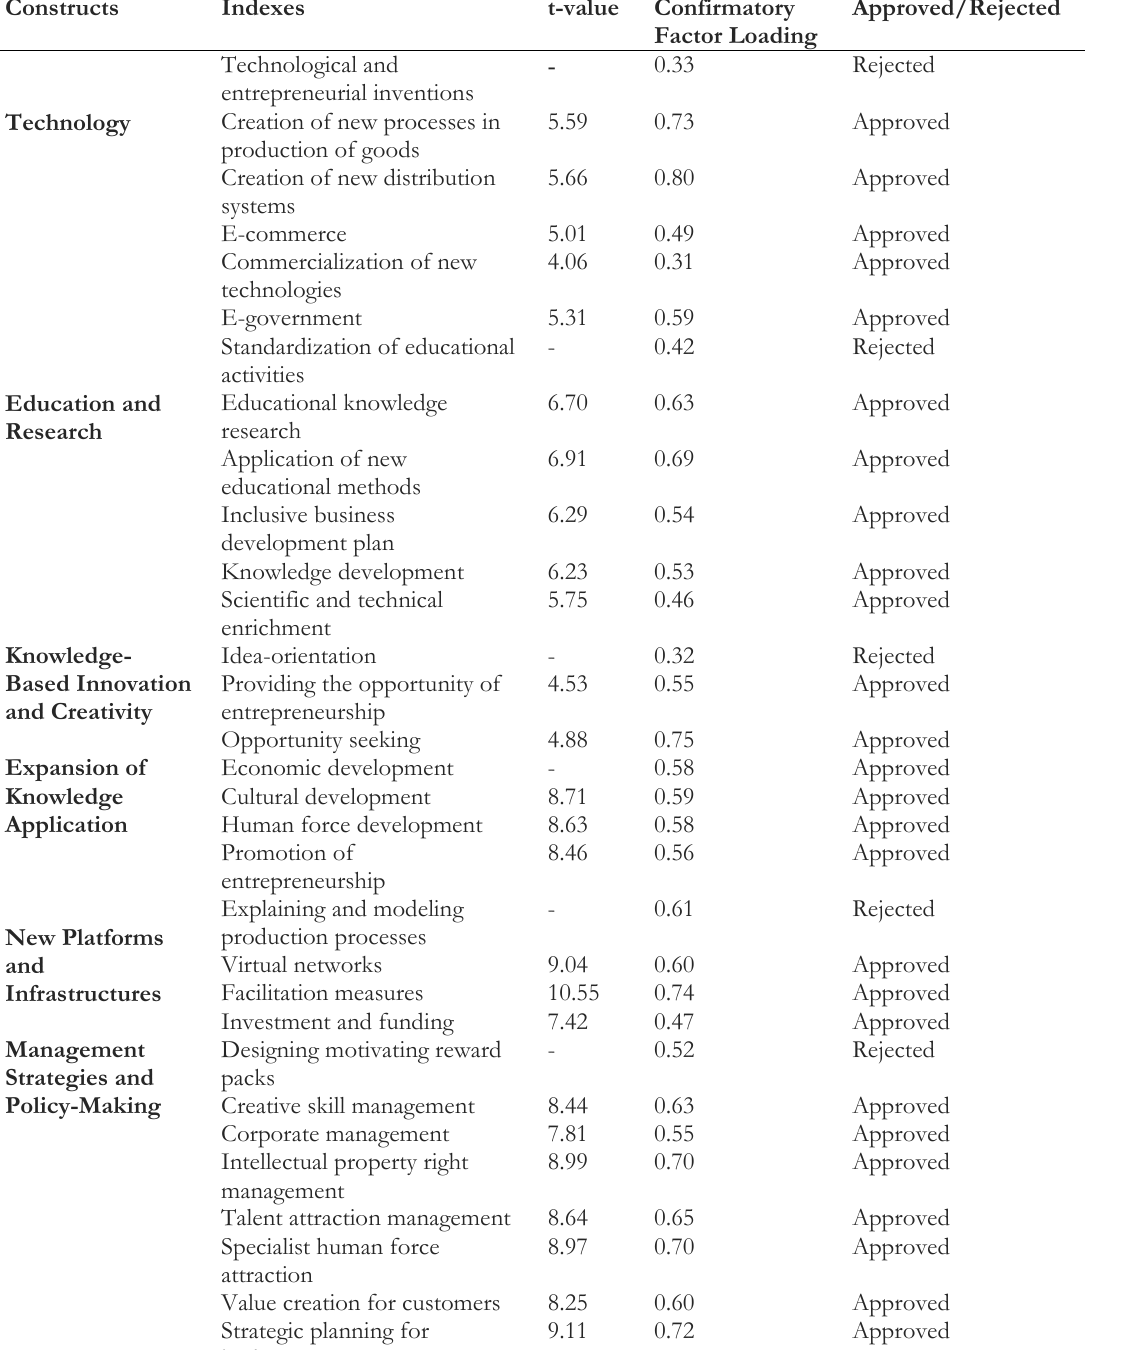
Table 8. The relationships between the